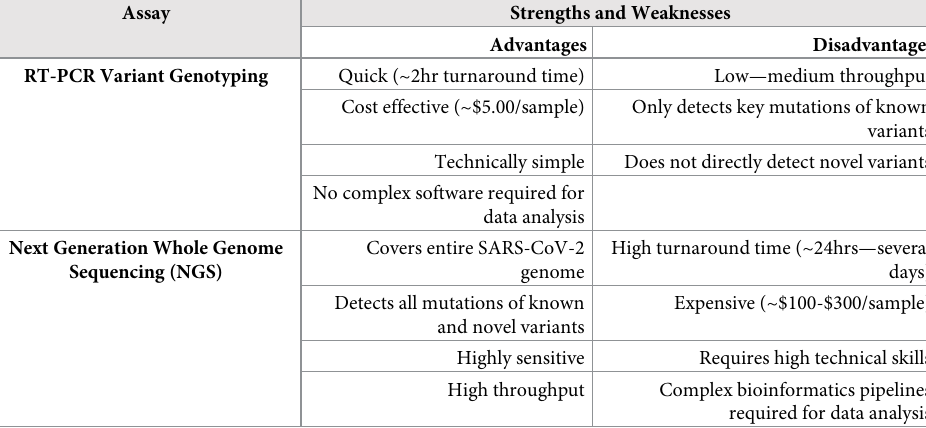
Table 4. Comparing strengths and weaknesses of RT-PCR variant genotyping and whole genome sequencing. Time to results (turnaround time), cost, technical expertise are contrasted between the two